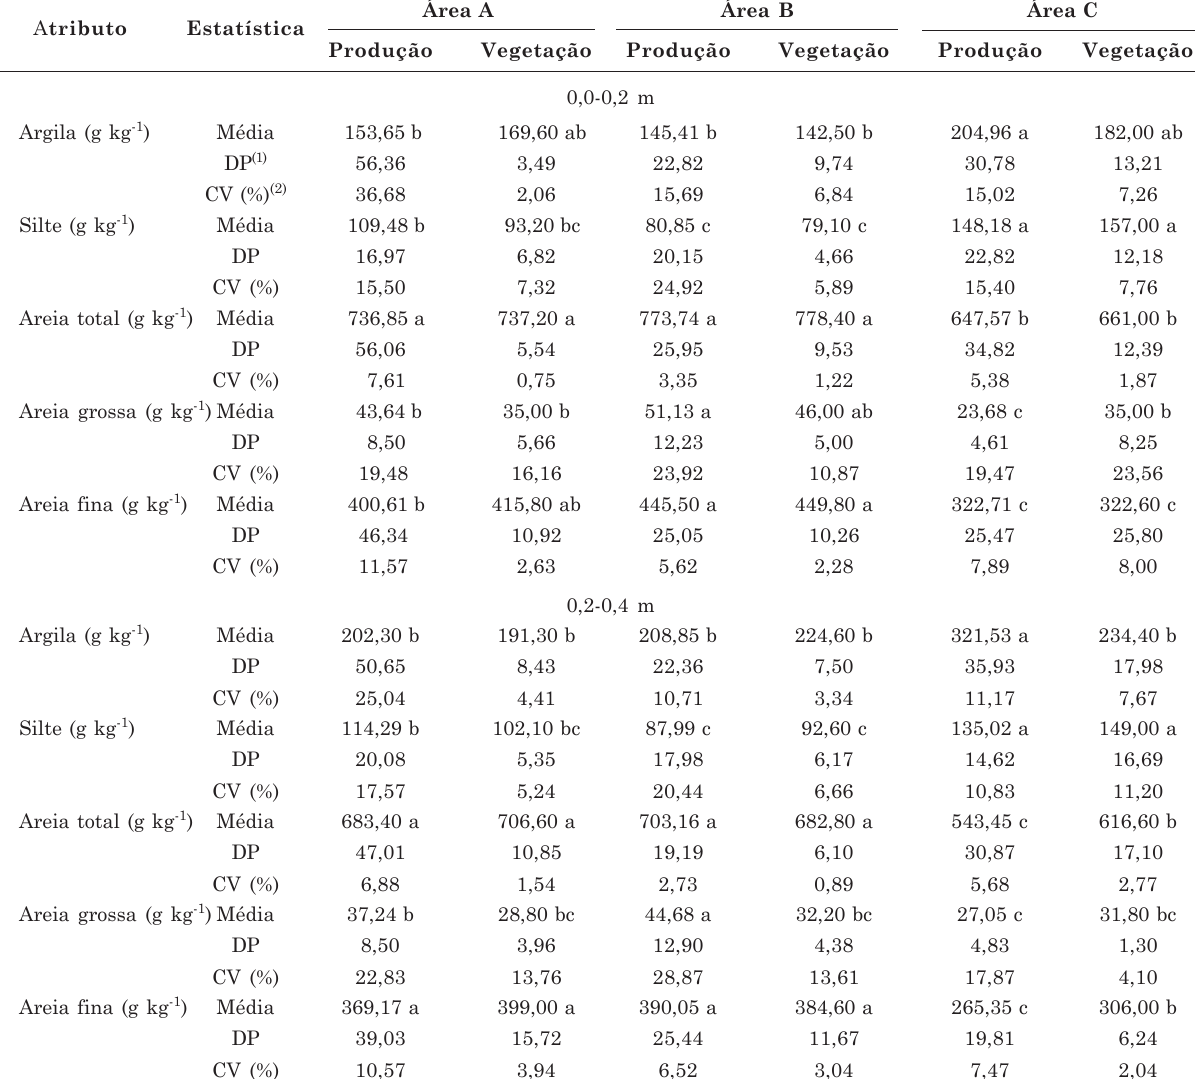
Quadro 1. Valores médios dos atributos granulométricos dos solos estudados nas profundidades de 0,0-0,2 e 0,2-0,4